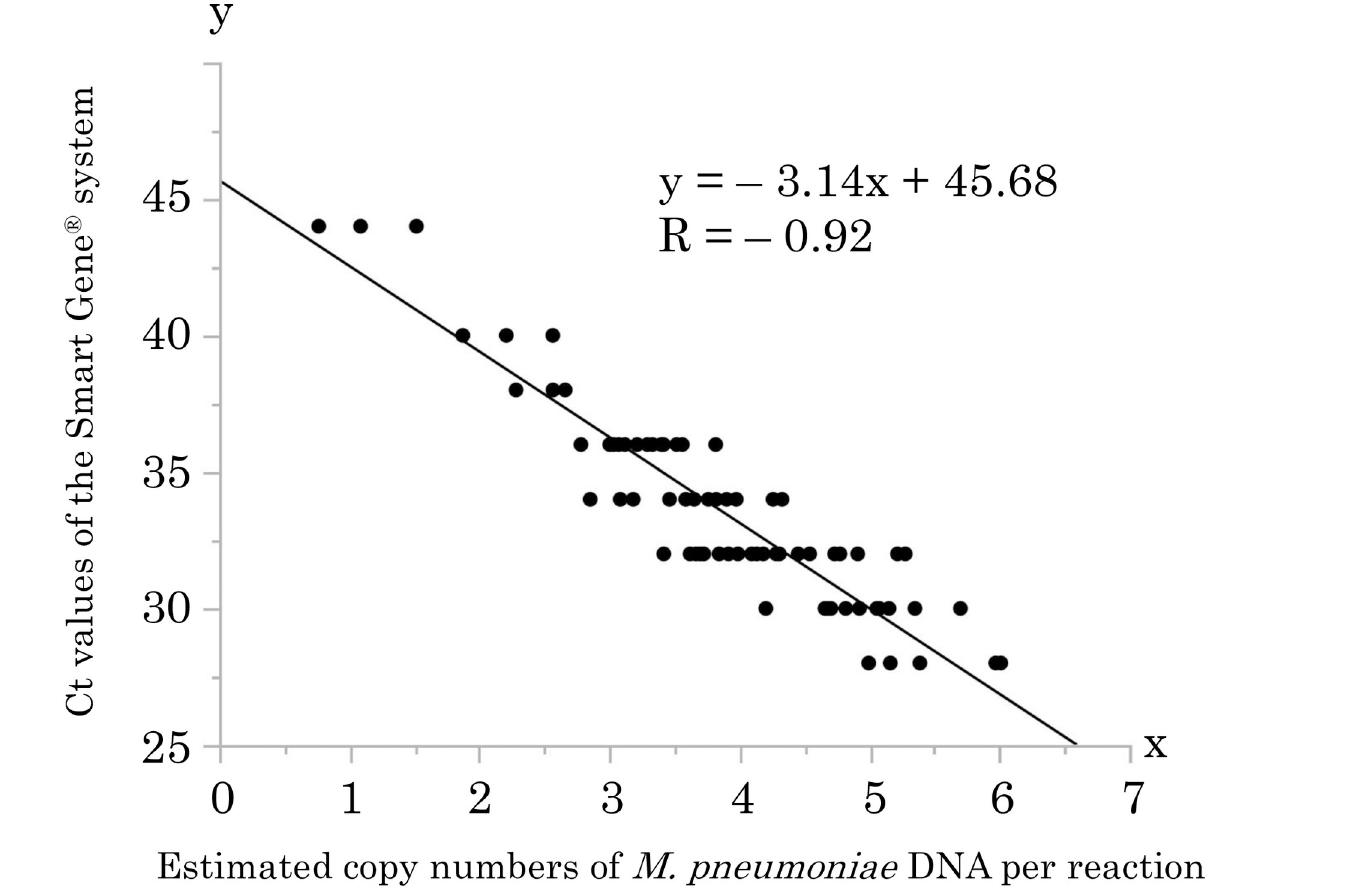
Fig 4. Correlation between Ct values of the Smart Gene 1 system and copy numbers of M . pneumoniae DNA measured by qPCR. Scatter plots and fitted line showing a strong negative linear association (correlation coefficient = -0.92 (p < 0.0001)) between Ct values of the Smart Gene 1 system and estimated copy numbers of M . pneumoniae DNA per reaction of the Smart Gene 1 system calculated from values of